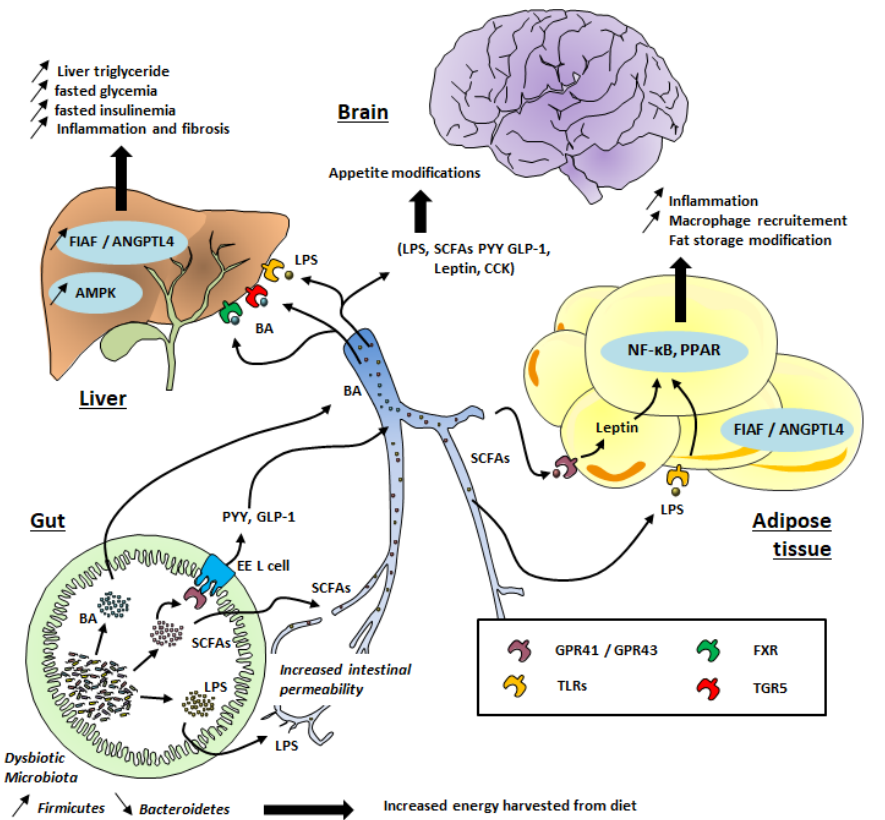
Figure 1. Gut microbiota’s contribution to obesity development. TLR: Toll-Like Receptor; GPR: G-protein coupled receptor; FXR: Farnesoid X Receptor; TGR5: Takeda G protein-coupled receptor 5; SCFAs: Short-Chain Fatty Acids; LPS: lipopolysaccharides; PPAR: Peroxisome proliferator-activated receptors; FIAF: Fasting-induced adipose factor; ANGPTL; angiopoietin-like protein; BA: Bile Acid, EE, Entero-endocrine cells; CCK: Cholecystokinin; PYY: peptide tyrosine tyrosine; GLP-1: Glucagon-like peptide 1; AMPK: AMP-activated protein kinase, NF- κ B: Nuclear factor- kappa B.